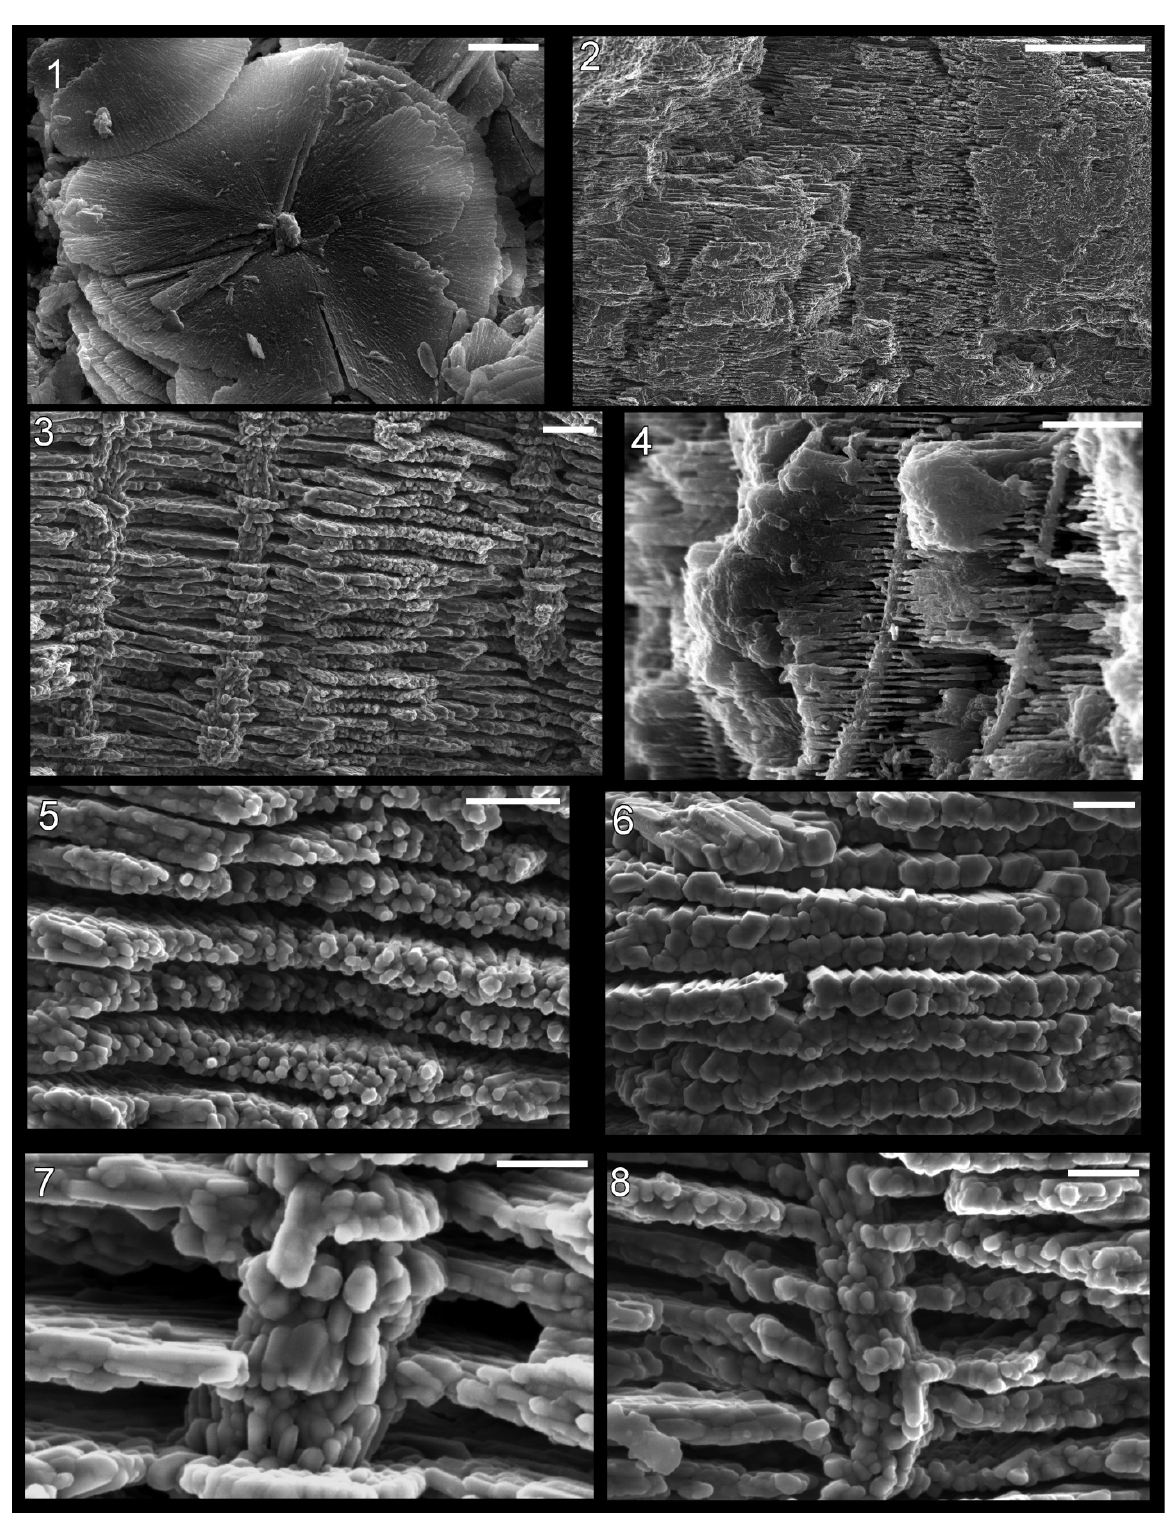
Figure 3. Shell microstructure in specimens of Isorthoceras from the Ordovician Maquoketa Formation. ( 1 ) LACMIP 14434, horizontal view of disc in middle shell layer, proximal region of the shell, topmost disc is the most external; ( 2 )–( 4 ), ( 7 ) and ( 8 ) LACMIP 14437; ( 5 ) and ( 6 ) LACMIP 14438. ( 2 )–( 8 ) Transverse sections of middle or inner shell layer where the top of the photograph is external. Scale bars: 5 µm for ( 1 ), ( 2 ) and ( 4 ); 1 µm for ( 3 ); 500 nm for ( 5 ) and ( 6 ); 200 nm for ( 7 ) and ( 8